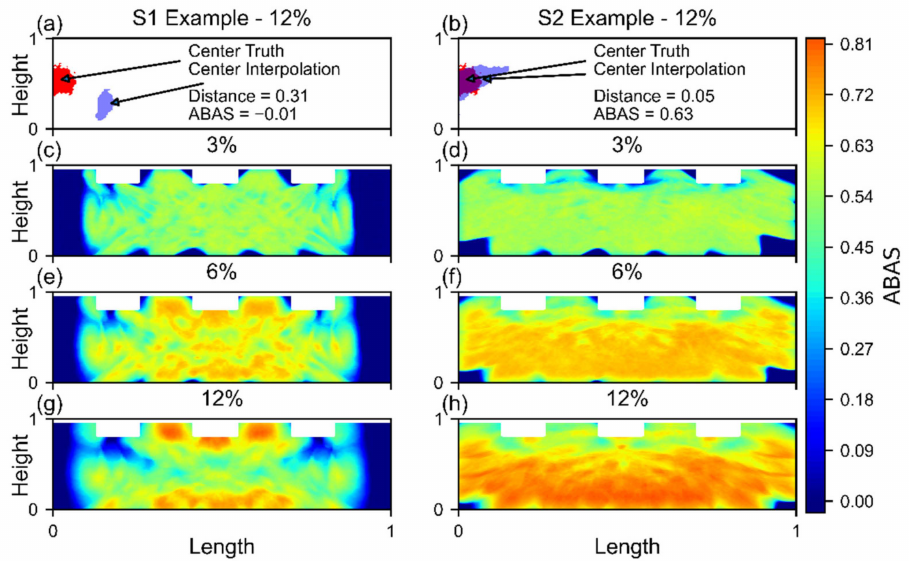
Figure 8. Interpolation and defect detection results obtained with the proposed algorithm. Illustration of a specific 2D toy example for S1 ( a ) and 2 ( b ). Colormaps of ABAS results for one-defect cases and S1 with 3% ( c ), 6% ( e ), 12% ( g ) defect sizes and the same for S2 ( d , f , h ). The color represents the ABAS obtained for the example with a defect centered in the pixel’s position. The anode dimensions (height and length) are